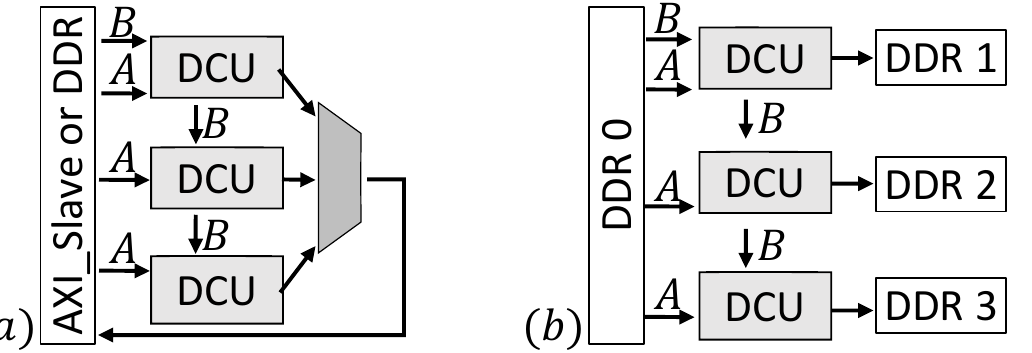
Figure 5. Two exemplary design options with three DCUs. A : Static signature B : Dynamic signature. ( a ) Inputs are streamed from an AXI- or DDR-interface. Results of the DCUs are combined and send back ( b ) Four DDRs, one providing the inputs and three to store